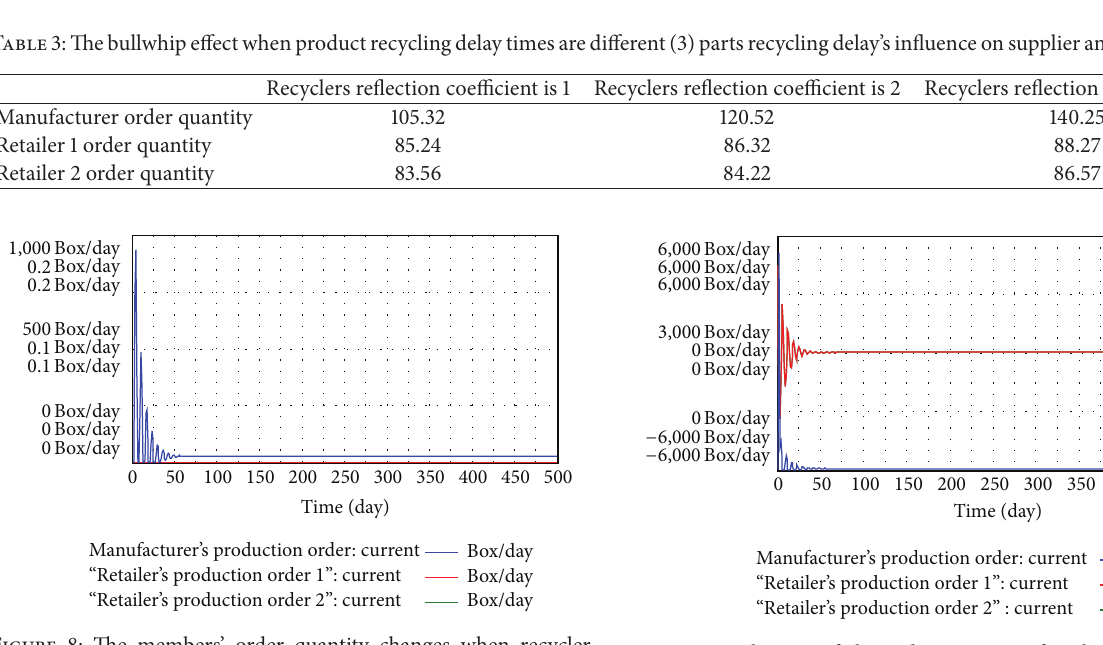
Figure 9: Changes of the order quantity of each member when recycled product delay time is 14.